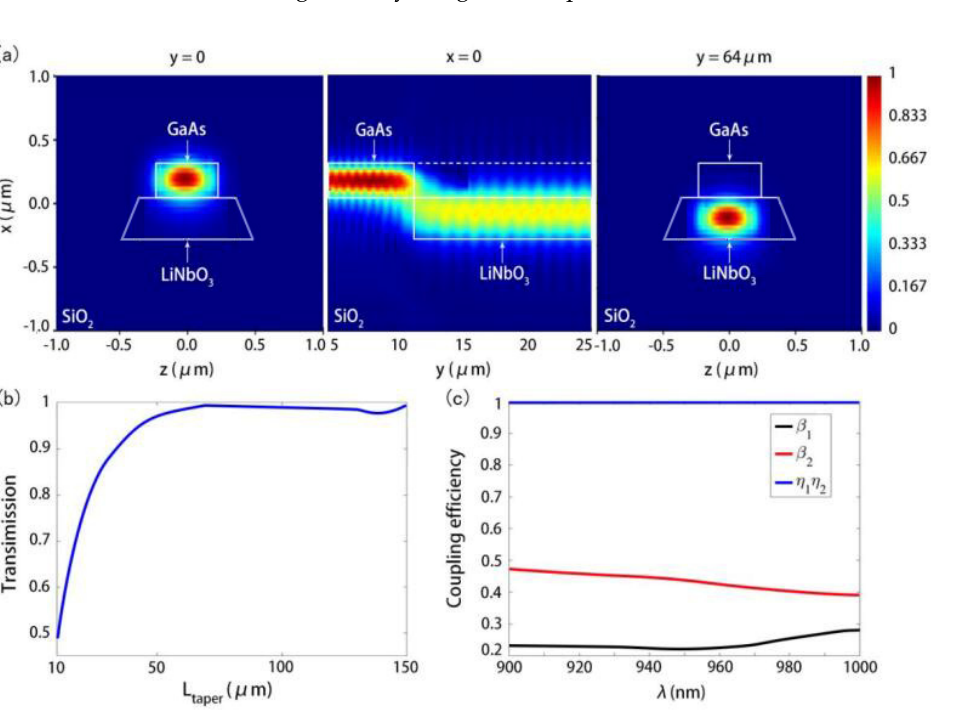
Figure 2. ( a ) Simulated amplitude of electric field (|E| 2 ) of partial cross-sections of the light source under different x-coordinates. Left-hand (x = 0, y = 0, and z = 0), middle (x = 0, 5 μ m < y < 25 μ m, − 1 μ m < z < 1 μ m), right-hand (x = 0, y = 64 μ m, z = 0); ( b ) the transmittance of the directional coupler versus the taper length (L taper ). The dip at around 145 μ m is induced by the limit in the numerical accuracy in the simulation; ( c ) the coupling efficiency of the GaAs taper to the LiNbO 3 waveguide with (red line) and without (black line) the Bragg mirror. The blue line represents the efficiency of waveguide mode coupling into lithium niobate.